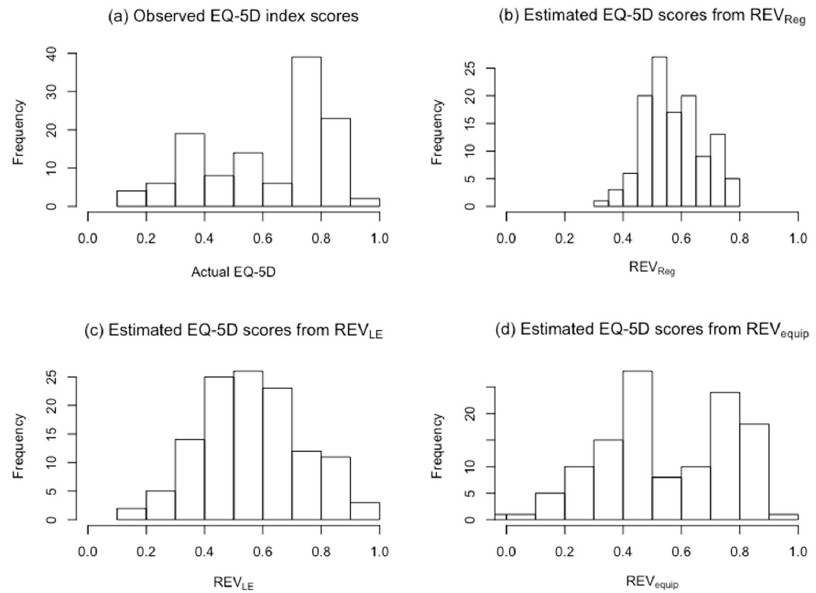
Figure 3. Histograms of observed EQ-5D index scores and estimates from REV Reg , REV LE , and REV